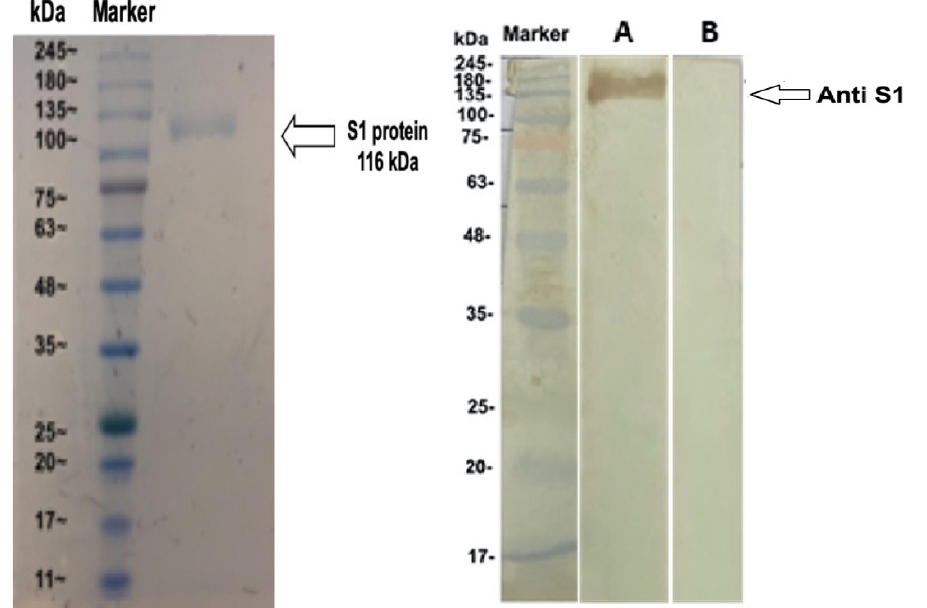
Figure 3. Western blot analysis of anti-MERS-COV rS1 IgY antibodies. (Left) The S1 protein of MERS-COV was subjected to SDS-PAGE under reducing conditions; (Right) Western blot analysis of the anti-S1 IgY antibody response. SDS gels were electrically transferred onto nitrocellulose membranes and probed with IgY from immunized and nonimmunized hens (marker: molecular maker; lane A: S1-immunized IgY; lane B: adjuvant-immunized IgY). The strips were processed separately and pasted beside each other for documentation.